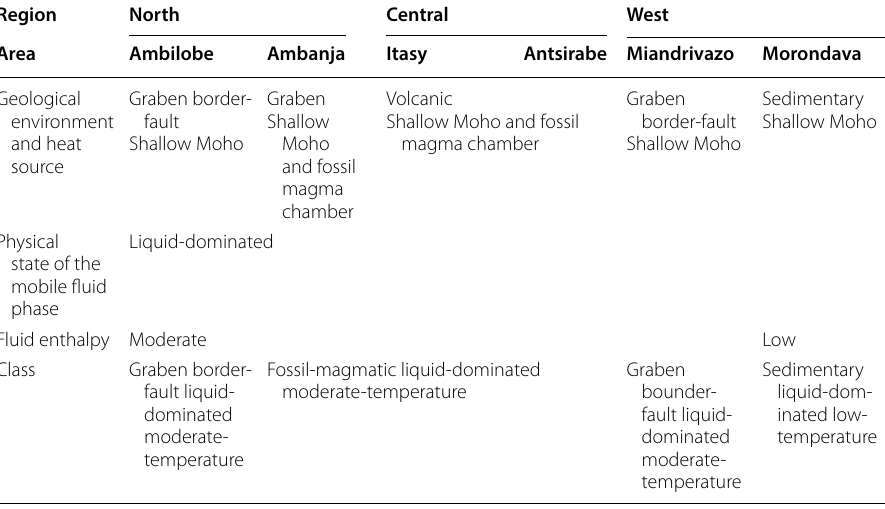
Table 4 Geothermal system classes for prospective areas in Madagascar